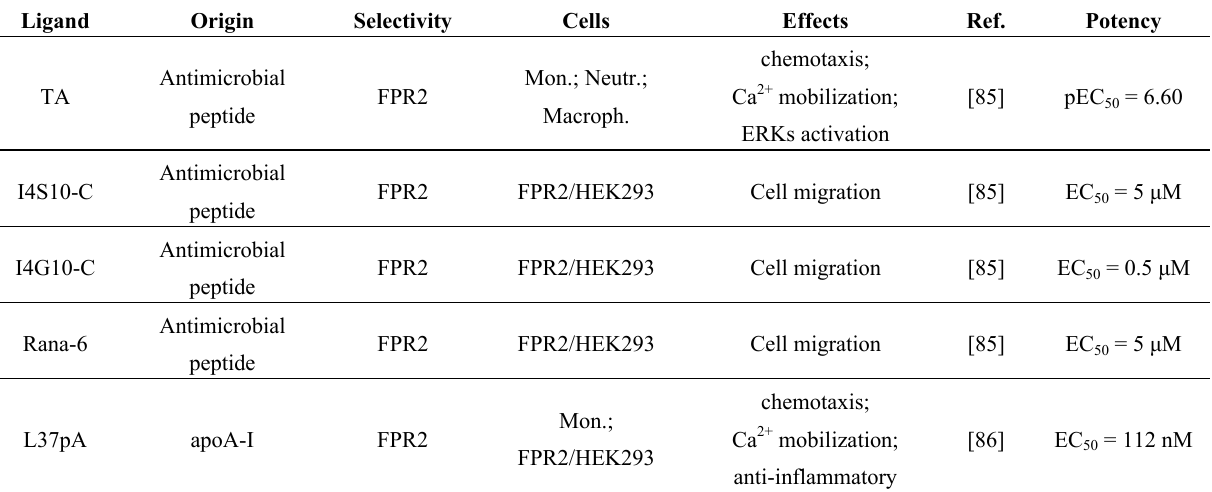
Table 6. Intracellular signaling cascades triggered by other endogenous